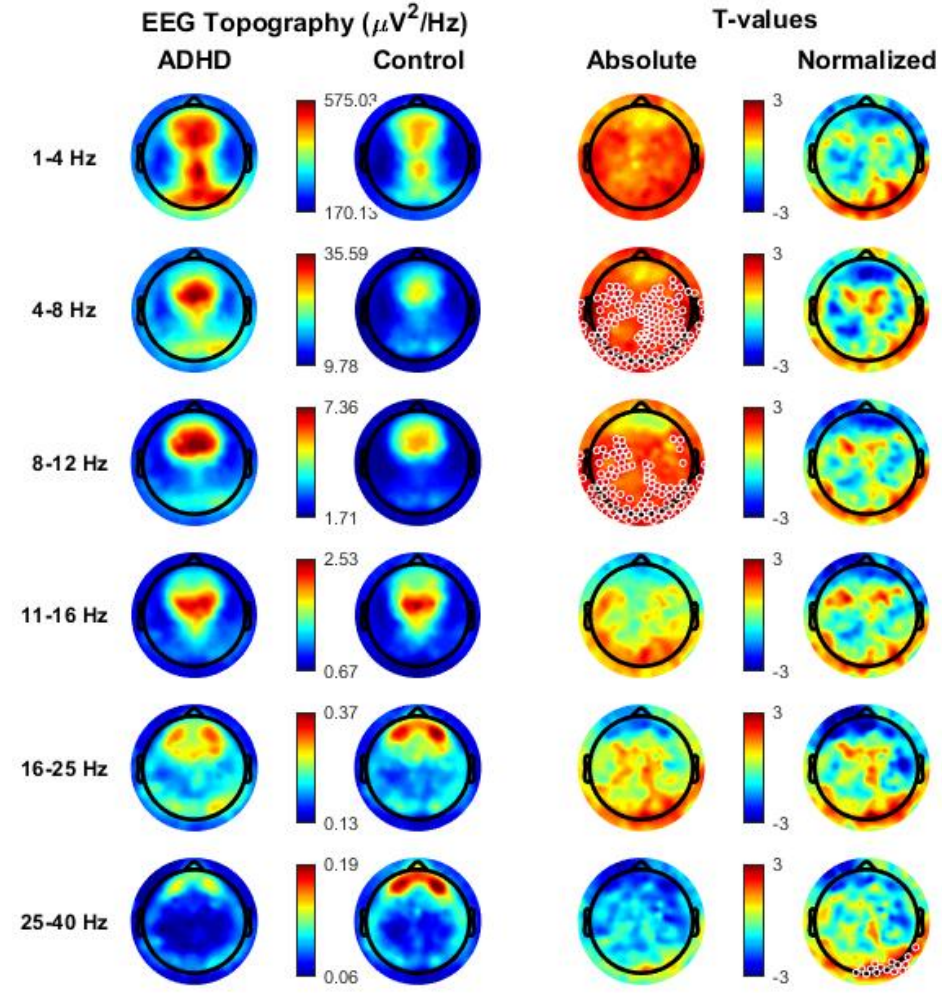
Figure 2. Topographical distribution of all frequency bands based on whole-night non-rapid eye movement (NREM) sleep stage 3 (N3) in the attention-deficit/hyperactivity disorder (ADHD) group and in the healthy control group. Values are color-coded and plotted on the planar projection of the hemispheric scalp model. Rows: frequency bands of interest. First and second column: average N2 sleep EEG topographies across frequency bands for children with ADHD and healthy control matches, respectively. Maxima are shown in red, minima in blue. Third and fourth column: single electrode t -value (2-tailed, unpaired) maps for the comparison between patients with ADHD and control subjects in terms of absolute and normalized (using the z-score across all electrodes) power, respectively. Blue color: decrease in EEG power in patients with ADHD relative to healthy controls (ADHDs < controls), red color: increase in EEG power in patients with ADHD relative to healthy controls (ADHD > controls). White circles indicate significant electrodes ( p < 0.05 cluster-size